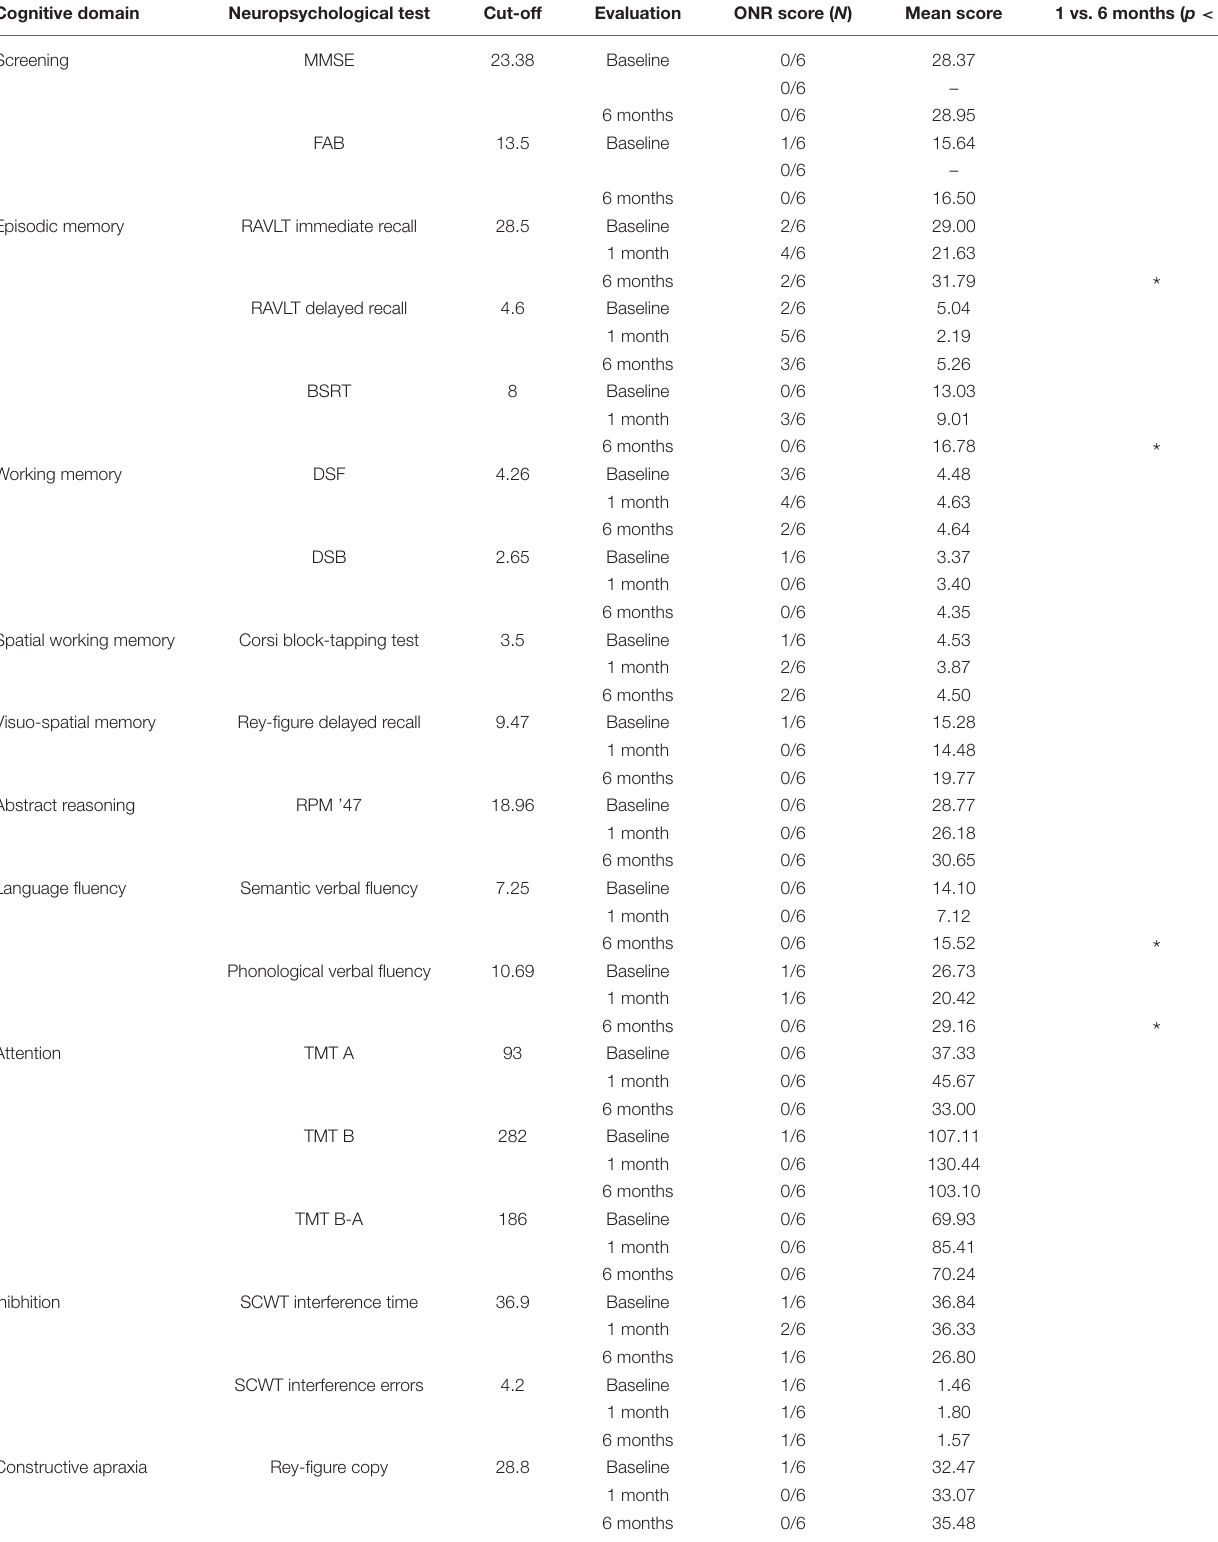
TABLE 1 | Neuropsychological evaluations: number of patients with out of normal range (ONR) scores and mean scores among the three evaluations are showed. Cognitive